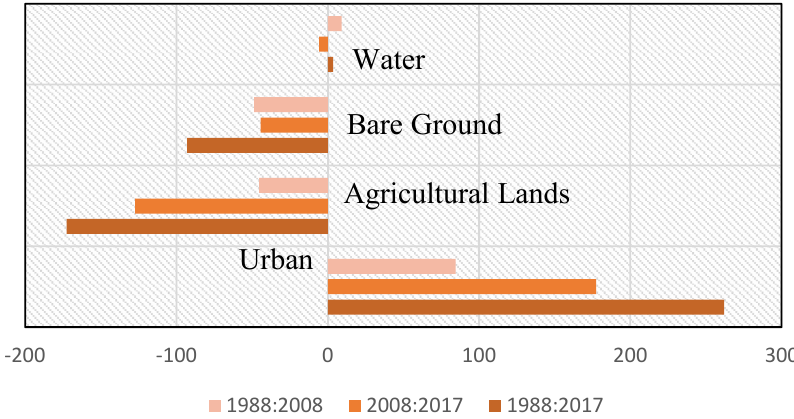
Figure 6. Total LULC net change within the ND flank including only cultivated lands. Urban areas are increasing in area, whereas both agricultural lands and bare ground are decreasing in area. These results are depictive of what is occurring in the ND, for they exclude the outlying perimeter influences.